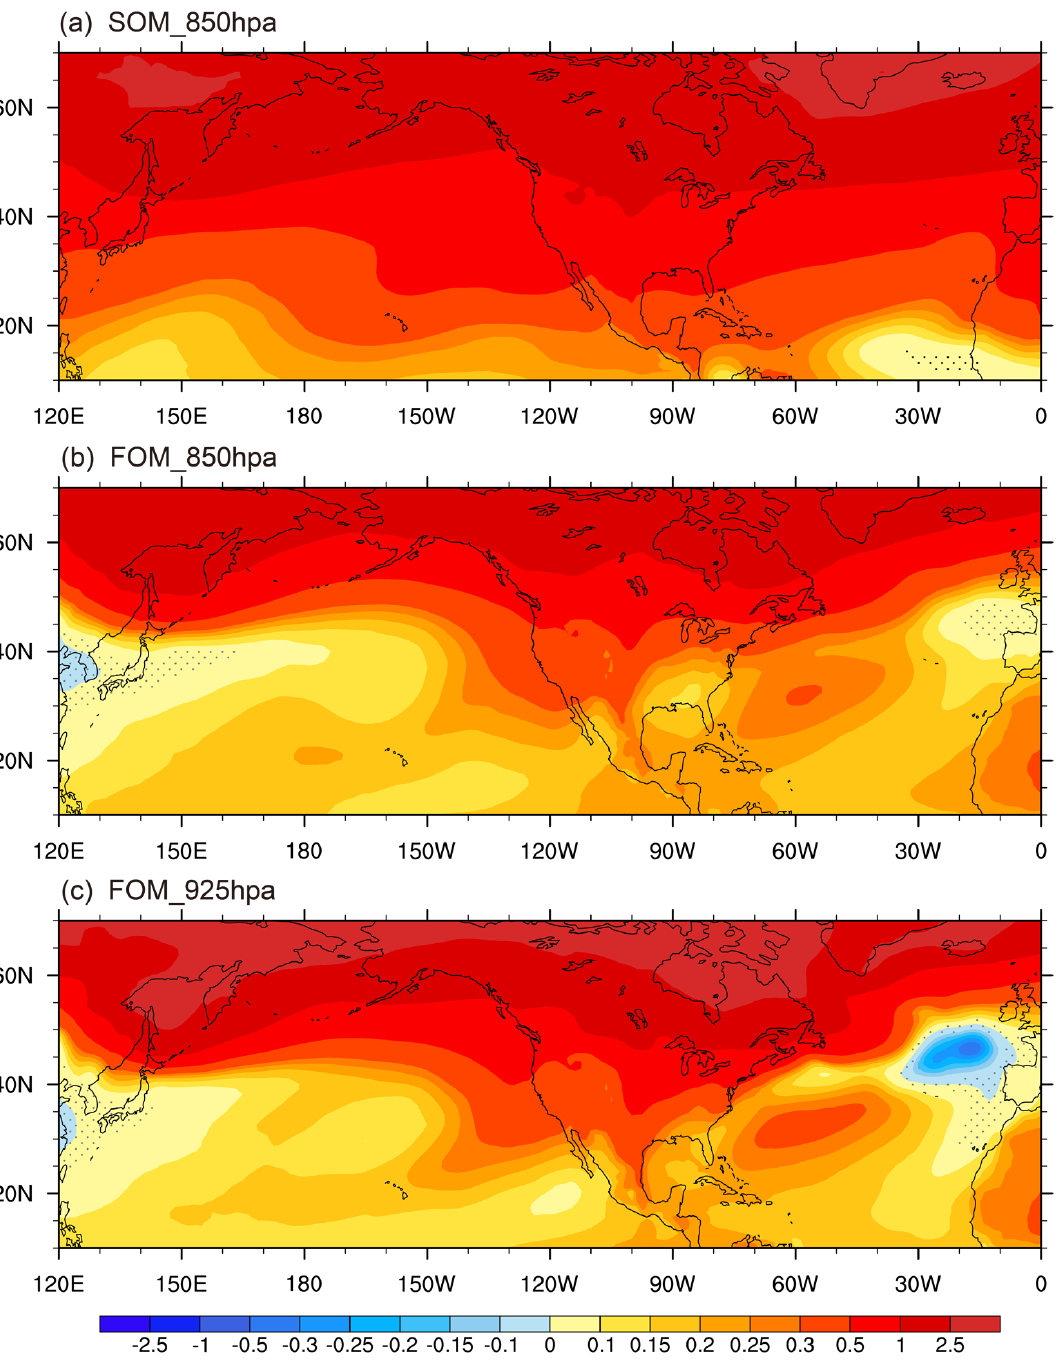
Figure 9. The quasi-equilibrium response of air temperature ( ℃ ) to Arctic sea ice loss at ( a ) 850 hpa level in SOM, ( b ) 850 hpa level in FOM, and ( c ) 925 hpa level in FOM. The values are statistically significant at the 95% confidence level except in the stippling regions.